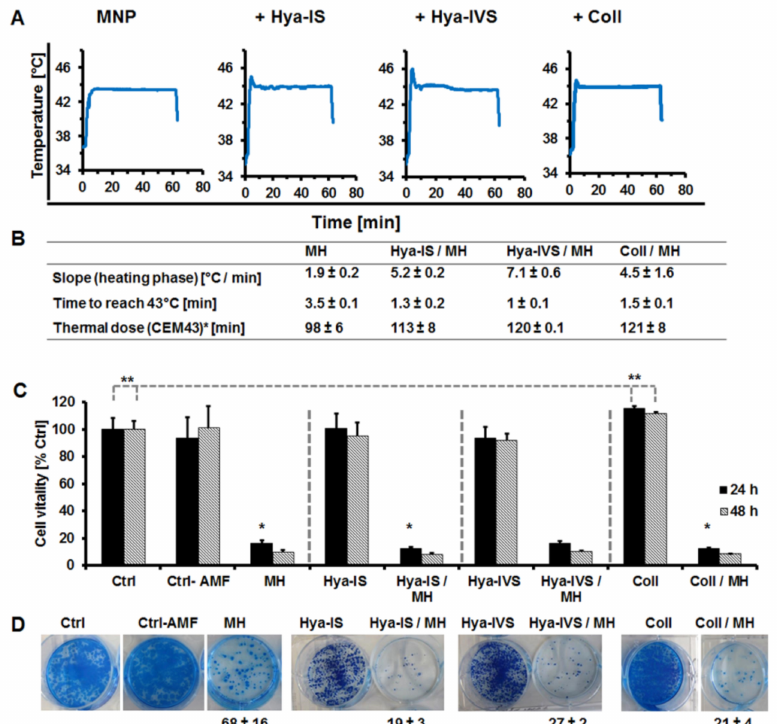
Figure 3. Influence of matrix-modulating enzymes on magnetic hyperthermia treatment of pancreatic cancer cells. ( A ) Representative heat curves of cells during exposure to an alternating magnetic field (AMF). ( B ) Cells treated with MNP alone (MH) reveal slower increase in temperature upon exposure to an AMF and lower overall heat dose (CEM43) after 60 min than those pretreated with hyaluronidase-IS (Hya-IS/MH), hyaluronidase-IVS (Hya-IVS/MH), or collagenase (Coll/MH) before incubation with MNP n = 3/S.D. ( C ) Relative vitality of cells grown for 24 and 48 h after magnetic hyperthermia treatment. * p < 0.05 signifies lower cell viability (higher cell death) for Hya-IS-/MH- and Coll-/MH-treated cells as compared to MH-treated cells. ** p ≤ 0.036 signifies higher cell viability (proliferation) for 24 and 48 h collagenase (coll)-treated cells as compared to control untreated Panc-1 cells. Each bar depicts the mean of n = 4/S.D. for control cells (Ctrl) and n = 3/S.D. for the treatment groups. ( D ) Representative pictures of well plates showing cells monitored for colony formation for 2 weeks after magnetic hyperthermia treatment. 5 × 10 3 cells were seeded per well. Enzyme- /hyperthermia-treated cells show higher ( p < 0.05) cell death and inability to form colonies than cells treated with MNP and hyperthermia (MH)